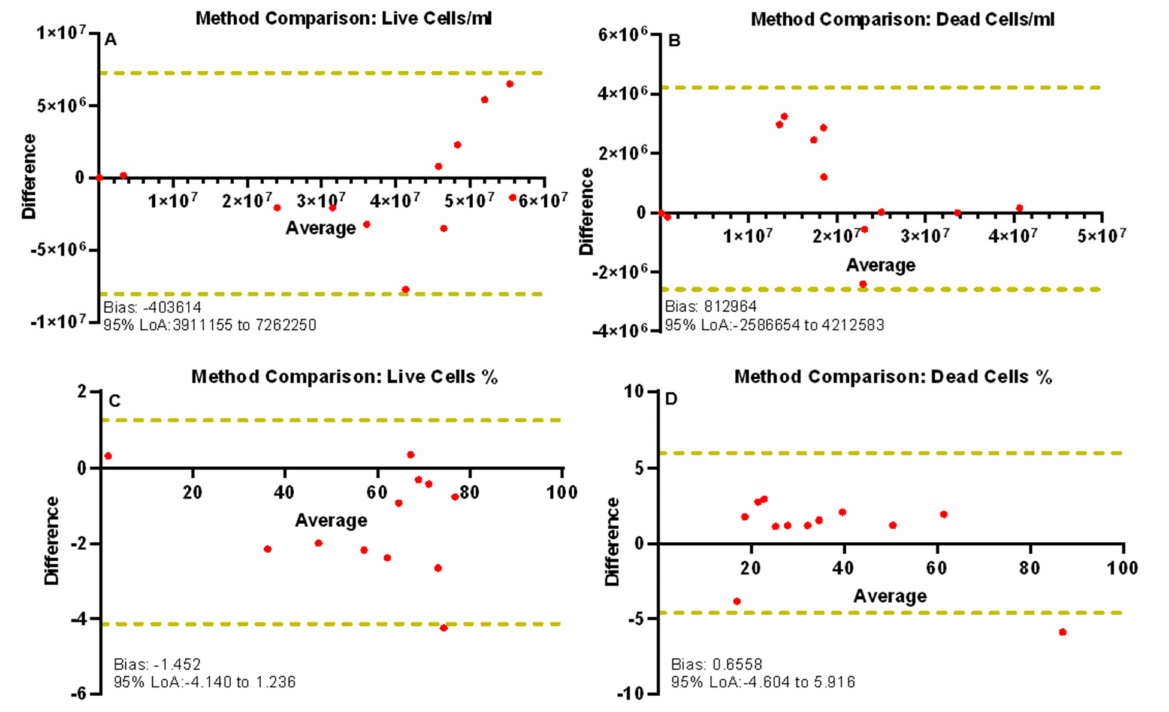
Figure 4. Bland Altman plots for method comparison. In this figure, x values represent the average of the two measures (i.e., [SYBR-PI value + CFDA-PI value]/2), whereas y values represent the difference between the two (i.e., SYBR-PI value − CFDA-PI value); bias indicates the average of the differences between the two methods. LoA: limit of acceptance. ( A – D ) method comparison for each parameter under investigation. ( A ) live cells/mL; ( B ) dead cells/mL; ( C ) % of live cells; ( D ) % of dead cells.